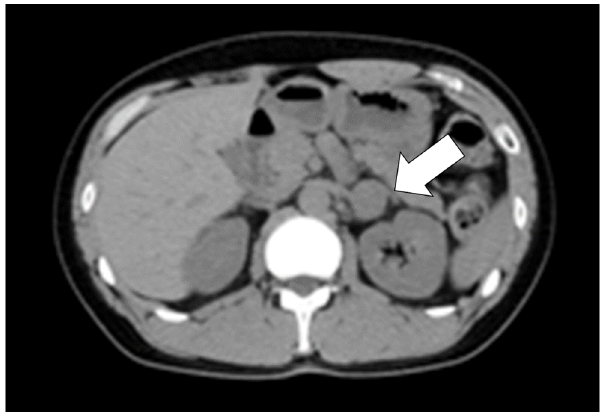
Figure 1. Abdominal computed tomography (CT) image of the patient in this case. Abdominal CT image during the first outpatient visit. Left adrenal adenoma (25 mm in diameter and 40 household- units) is shown (white arrow).